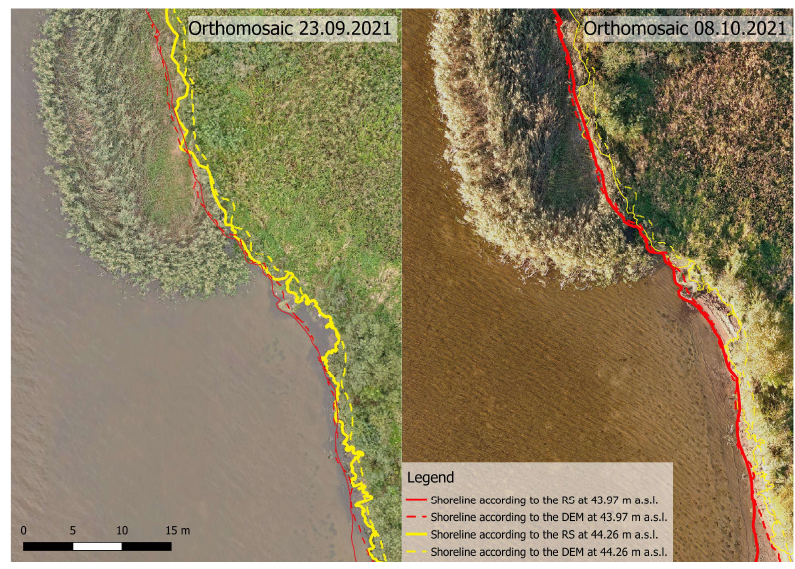
Figure 7. Shoreline detection comparison derived from traditional surveying and remote sensing.